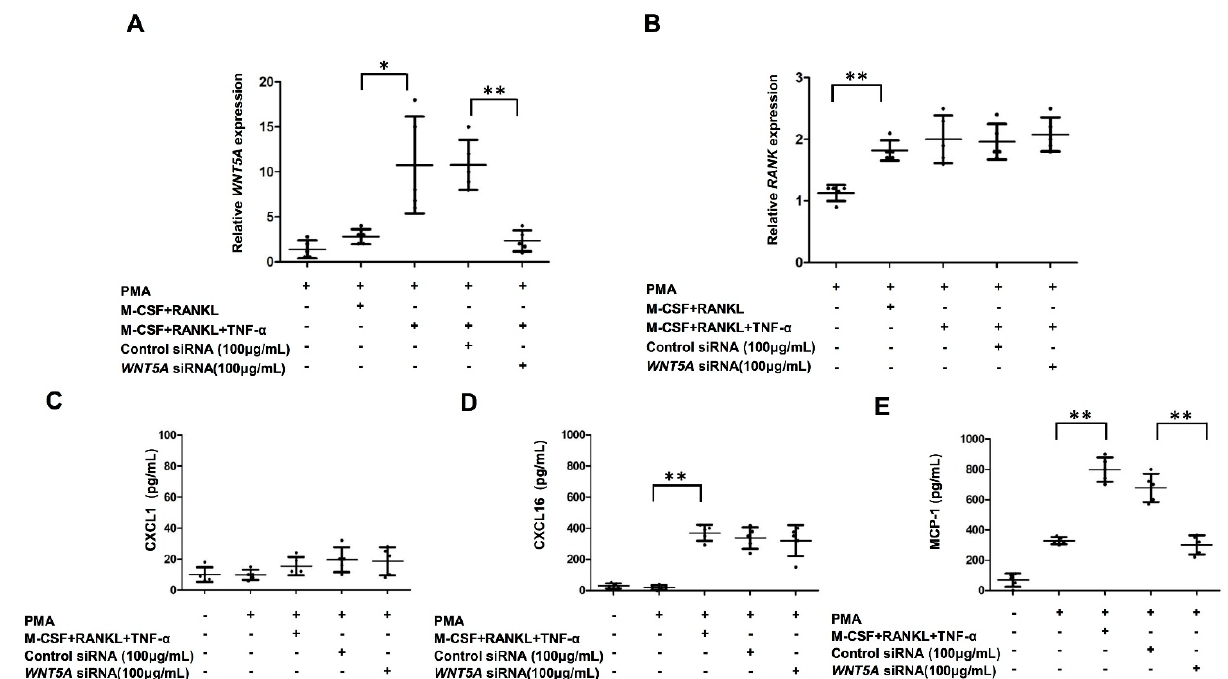
Figure 4. Increased production of MCP-1 in THP-1-cell-derived osteoclasts by combination of TNF- α , M-CSF, and RANKL was abrogated by WNT5A interference. THP-1-derived osteoclasts were transfected with control siRNA or WNT5A siRNA at 100 μ g/mL on Day 2 for 24 h. On Day 8, the THP-1-derived osteoclasts were obtained for further measurements and experiments. ( A ) The expression of WNT5A in THP-1-derived osteoclasts was measured using qRT-PCR. ( B ) The expression of RANK in THP-1-derived osteoclasts was measured using qRT-PCR. The levels of CXCL1 ( C ), CXCL16 ( D ), and MCP-1 ( E ) in the supernatant from THP-1-derived osteoclasts transfected with control siRNA or WNT5A siRNA were measured using ELISA. Data was obtained from five independent experiments. The error bar is the standard deviation of each data set. * indicates p < 0.05, and ** indicates p <